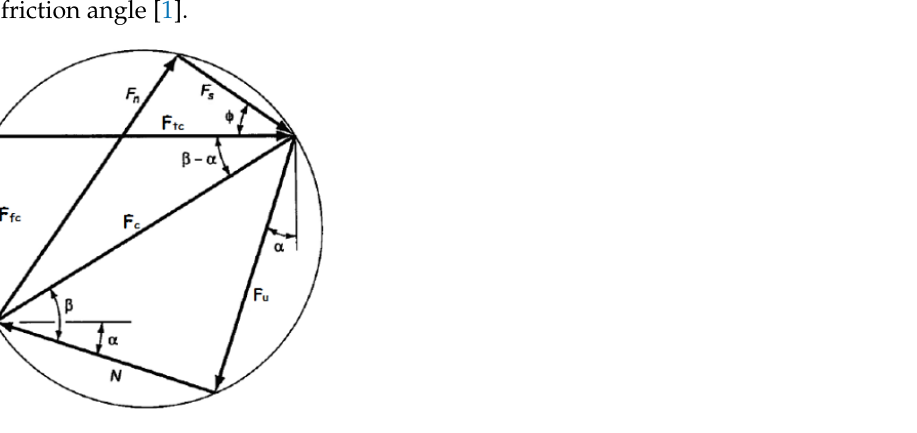
Figure 12. Force diagram of orthogonal cutting—Copyright @ 2020, John Wiley & Sons, Inc. [1].